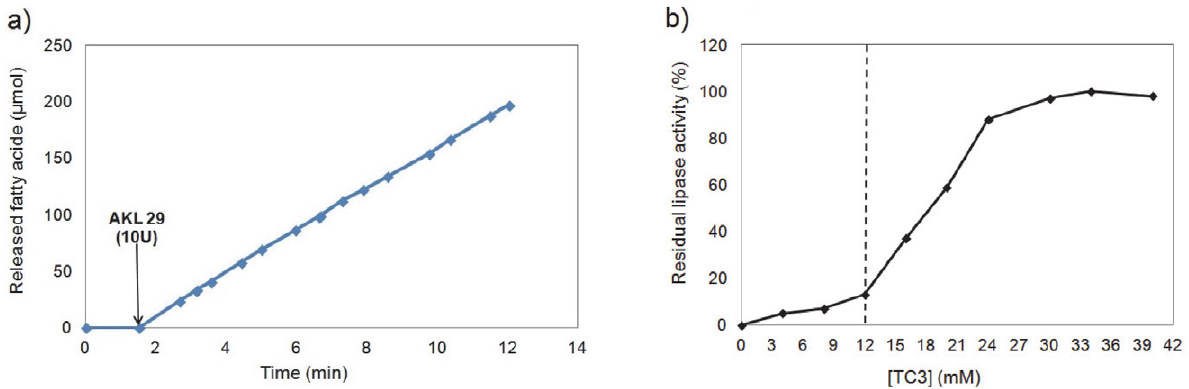
Figure 7 . Parity plot showing kinetic study of lipase using olive oil emulsions as substrate (a). Hydrolysis rate of TC3 by AKL29 as function of sub- strate concentration. The TC3 solutions were systematically prepared by mixing (3 × 30 s) in a warring blender agiven amount of TC3 in 30 ml of 0.33% GA and 0.15 M NaCl. The release of propionic acid was recorded continuously at pH 8 and 45 °C using a pH-stat. The solubility limit of TC3 (12 mM) is indicated by a vertical dotted line